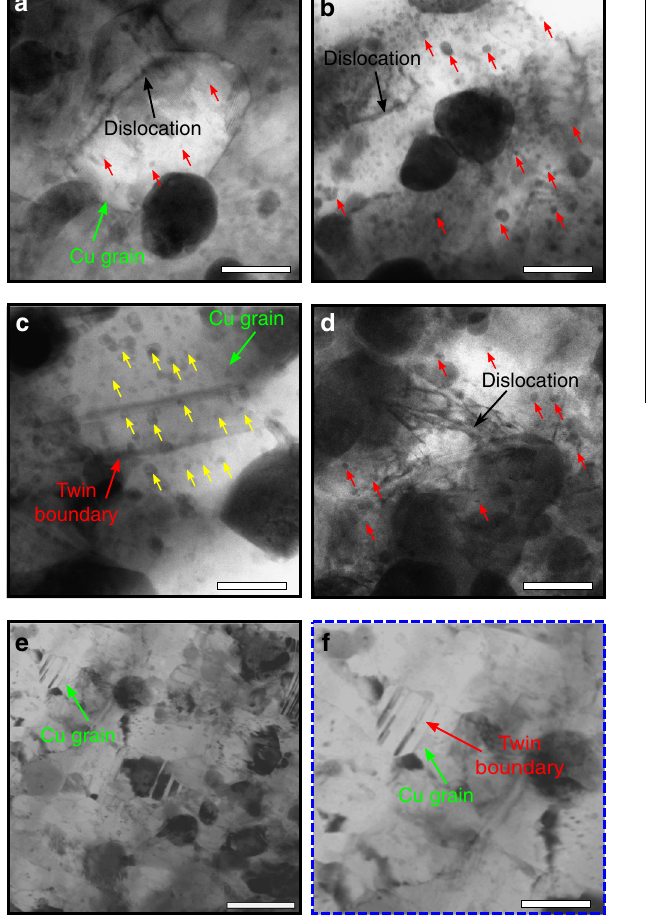
Table 1 The various strengthening mechanisms in